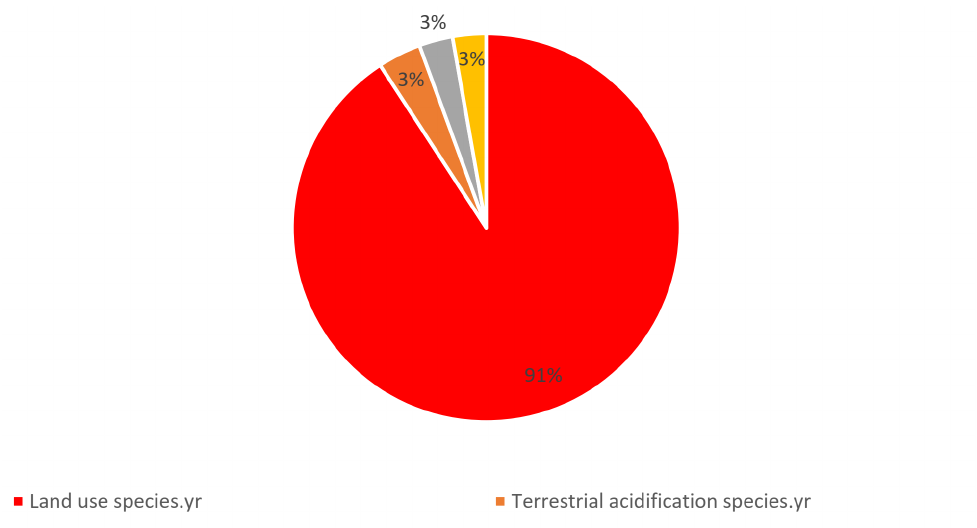
Figure 5. Contribution to Ecosystem of different impacts. Results are obtained with ReCiPe 2016—Endpoint (H) method.